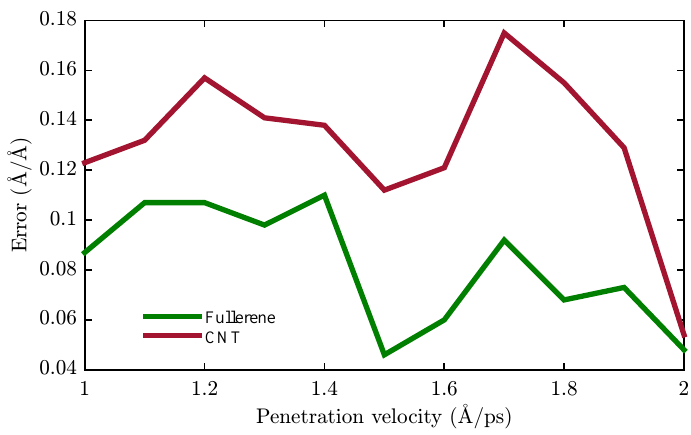
Figure 7. RMSD values of lipid bilayer atoms in the model for two different types of